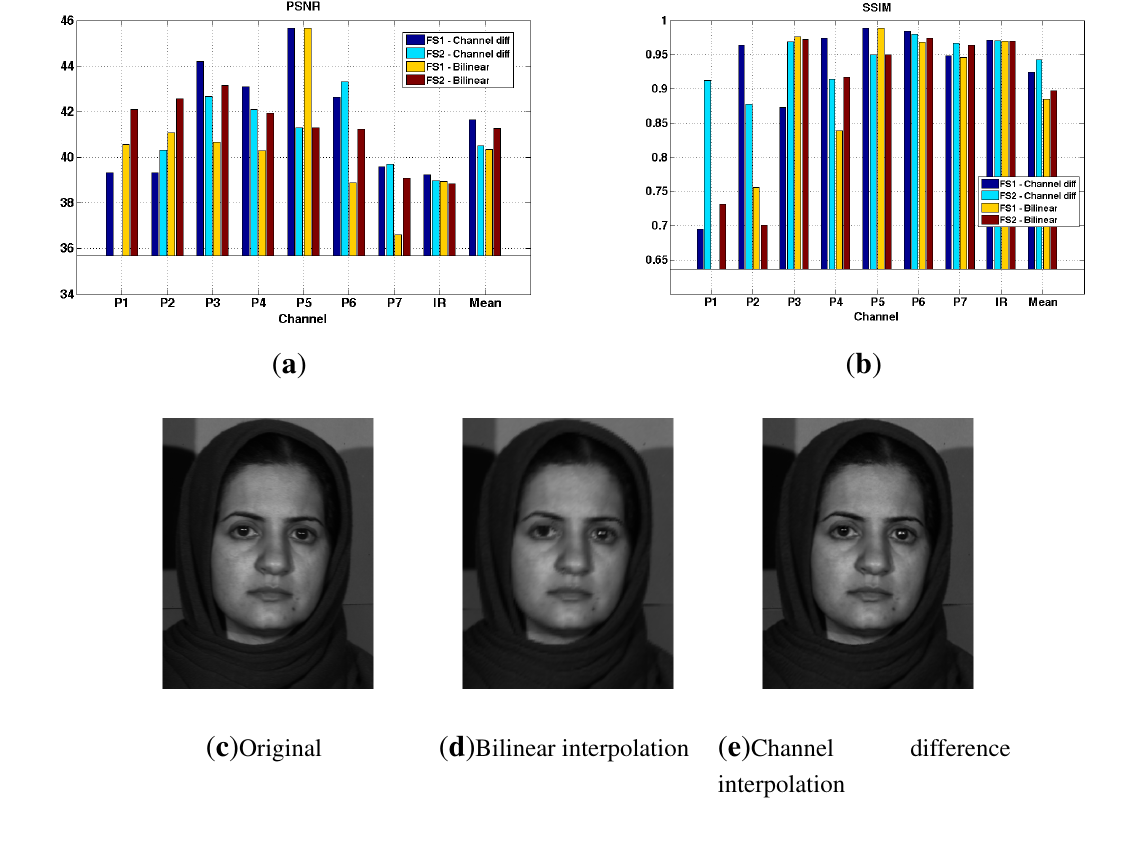
Figure 17. ( a , b ) Peak signal-to-noise ratio (PSNR) and structural similarity (SSIM) results of demosaicing simulation using the Skauli database [102]; ( c ) The ground truth image through the FS1 arrangement (P4 channel); ( d ) the image demosaiced by the bilinear interpolation and ( e ) the image demosaiced by the channel difference interpolation are